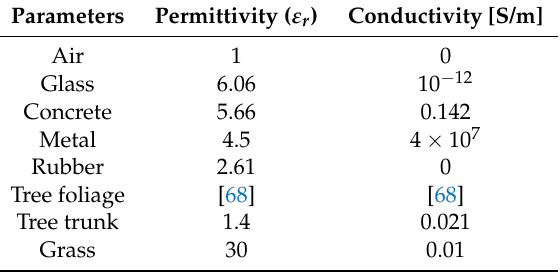
Table 4. Material properties for the 3D-RL